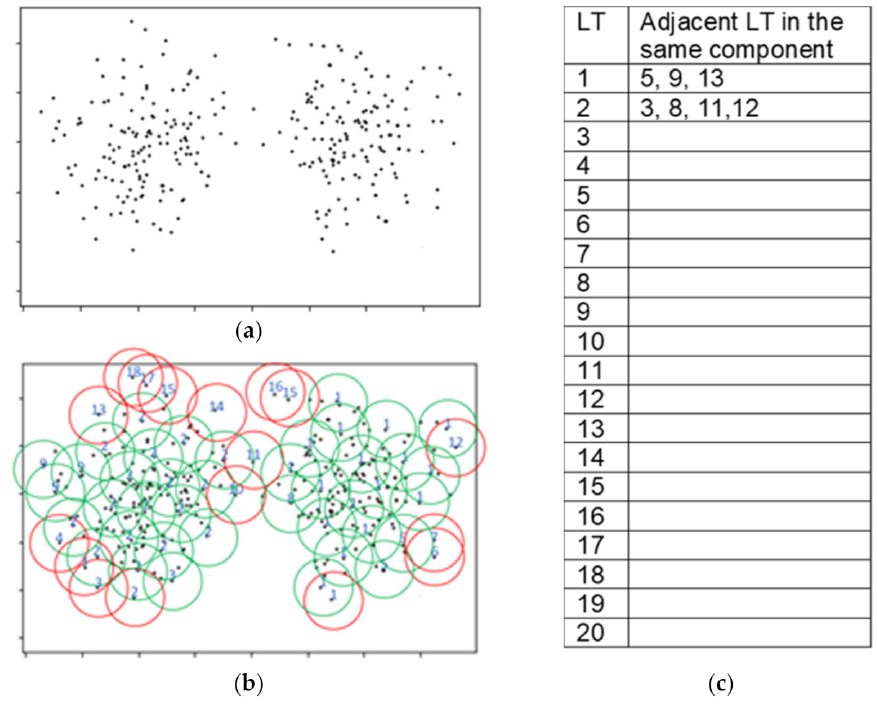
Figure 3. Example of the temporary labeling stage: ( a ) original datasets, ( b ) processing of data points; ( c ) resultant LL.